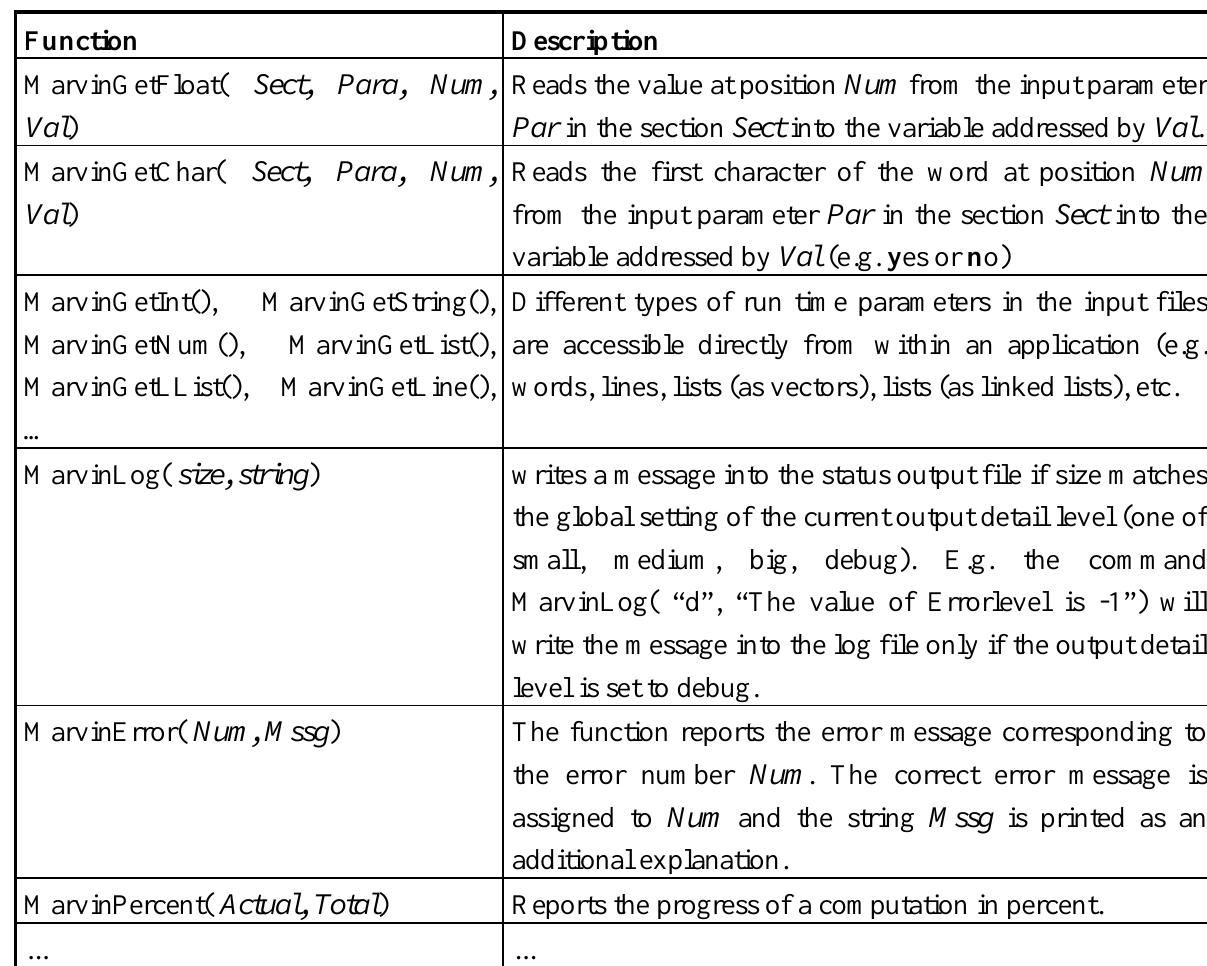
Table 4: marvin runtime library: Example user interface functions. Function